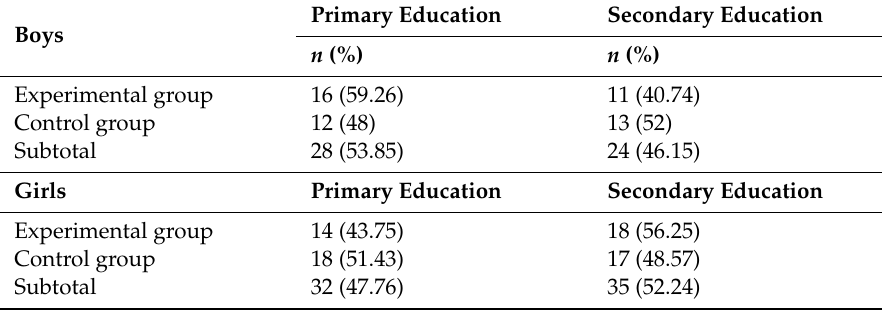
Table 1. Study groups by sex and educational